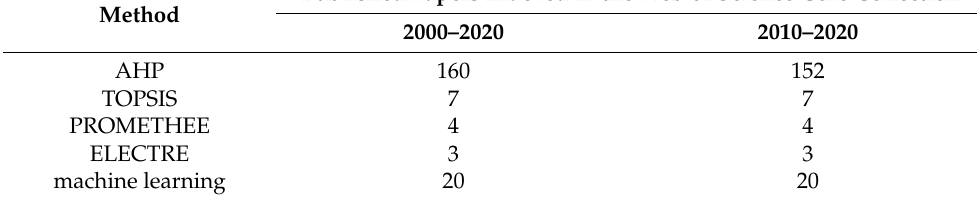
Table 2. Application of criteria weighting methods in cropland suitability studies indexed in the Web of Science Core Collection during the period of